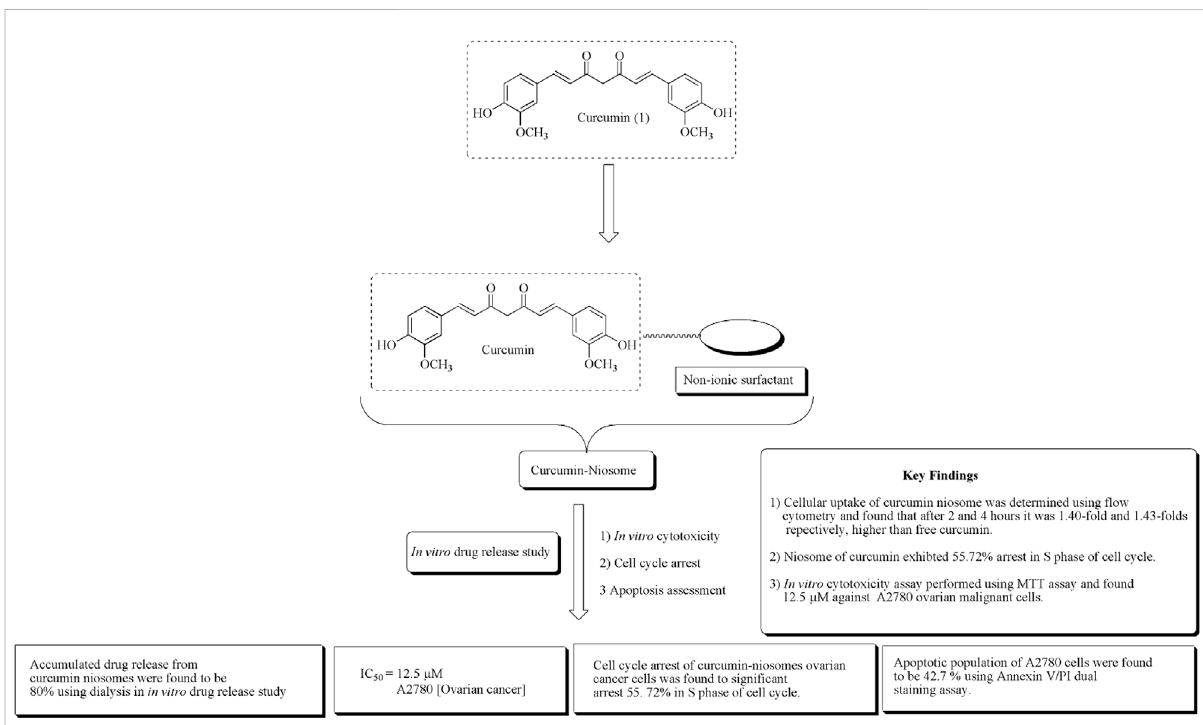
FIGURE 3 Structure of curcumin along with mechanistic insights of the curcumin niosome system. Curcumin niosomes were found to have a signi fi cant arrest in the S phase of the cell